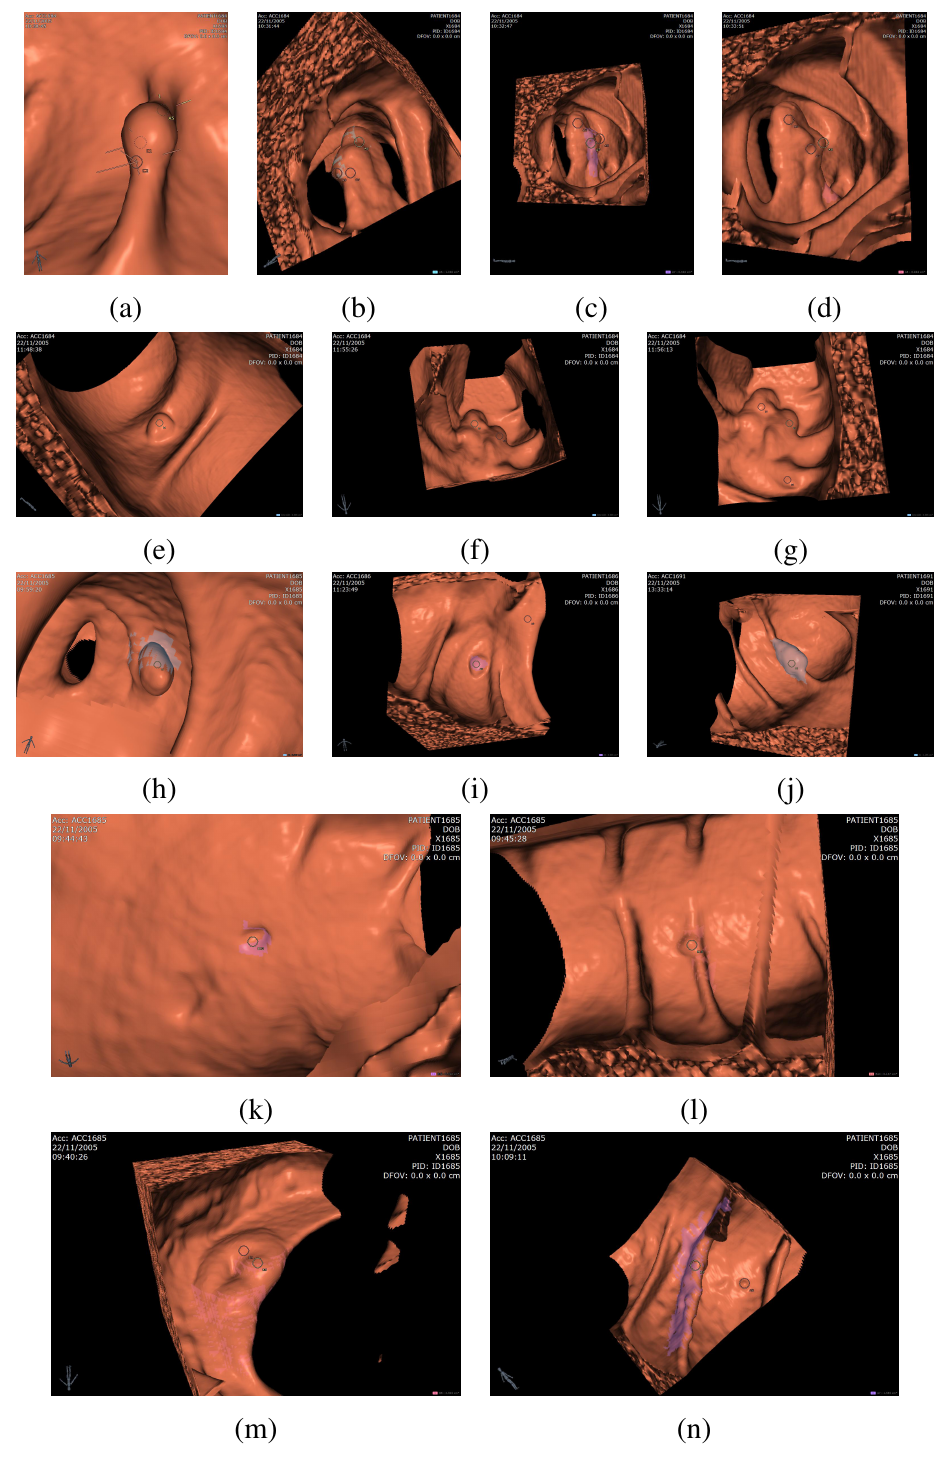
Figure 9. Examples of detected polyps and false positives, (a)-(l) are examples of detected polyps, (m)-(n) are examples of false positives. In particular, successfully detected sessile polyps appear in (e), (i), and (k), pedunculated polyps in (d) and (h), and polyps on folds in (a), (j), and (l). False positives shown in the figure relate to the ileocecal valve (m) and a thick fold